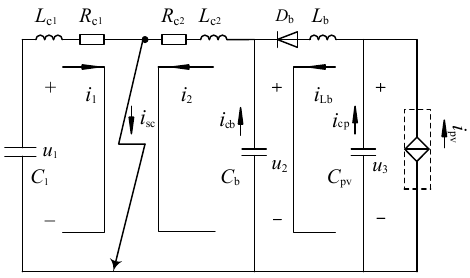
Figure 3. Equivalent circuits for the short-circuit fault at capacitor discharge stage.